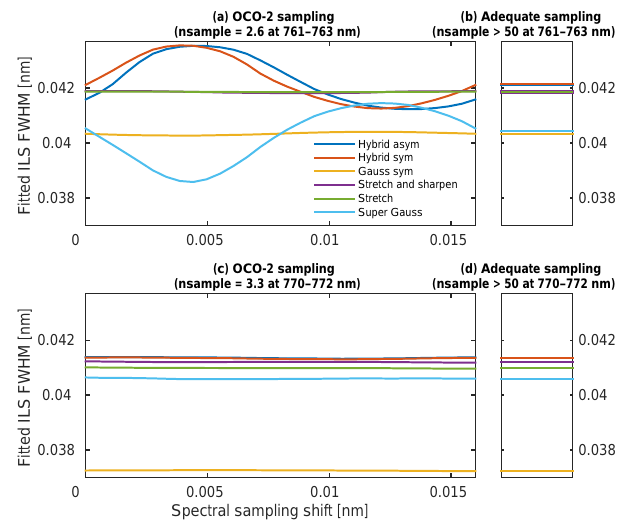
Figure 11. (a) The modeled, highly oversampled solar spectrum at 761–763nm was sampled using a sliding grid. The sampling grid of footprint 1 was used as the starting point. The sampled solar spec- tra was then fitted using six different ILS functions. (b) Fitting re- sults using the oversampled solar spectrum directly. (c, d) Similar to (a) and (b) but at 770–772nm.